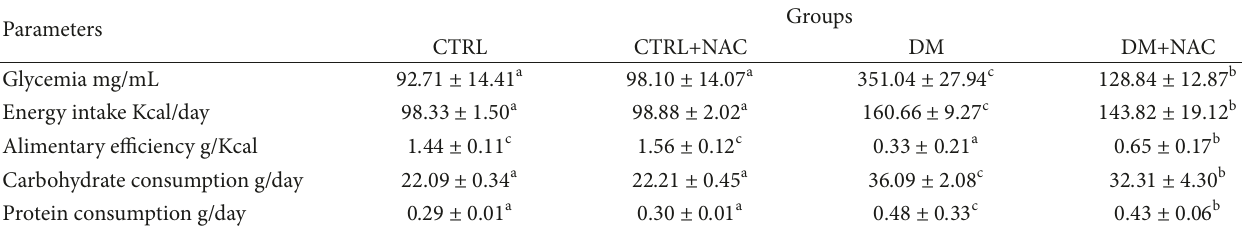
Table 1: Glycemia, energy intake, alimentary efficiency, carbohydrate, and protein consumption in diabetic rats that have been treated and not treated with NAC.